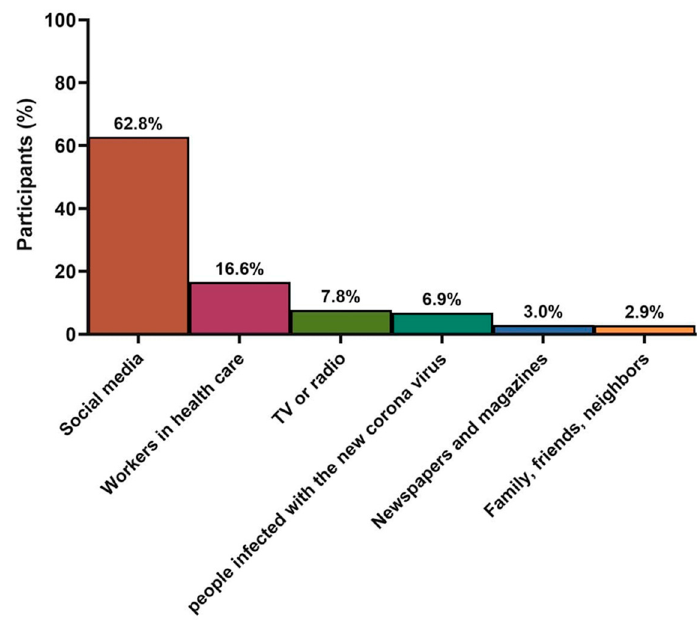
Figure 1. Sources of information about the novel coronavirus (COVID-19). Half of the participants (50.6%) identified all symptoms of COVID-19 properly, with fever (18.5%) and loss of smell and taste (17.1%) being the most frequently reported; however, only 2% of the participants did not recognize any of the COVID-19 symptoms. About one-quarter (25.5%) of the participants did not think that traditional medicine and dietary supplements would prevent or reduce the odds of contracting COVID-19 while 51.5% of them thought it may, and 23.0% said it would. Most of the participants (70.5%) disagreed with the statement that traditional medicines and dietary supplements would protect against COVID-19 more than the social distancing. In terms of using traditional medicines and dietary supplements to prevent COVID-19, 57.8% of the participants did not use them, 23.7% regularly did, and 18.5% sometimes did. Family members and friends sug- gested the use of traditional medicines and dietary supplements to 28.0% of the partici- pants while social media or other websites motivated 2.5%, and only 14.7% used those materials based on a piece of advice from a nutritionist, physician, pharmacist, nurse, or health worker (Table 2). Dietary supplements were mostly used (40.9%); however, 31.4% reported using tra- ditional medicines, 1.3% used yoga, and 1.7% used Chinese needles or cupping. Only